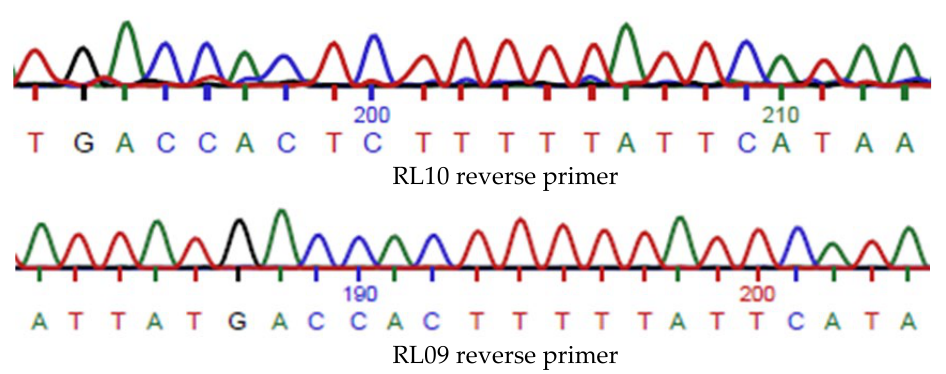
Figure A1. The sequence of the L. crispatus pulA signal peptide region of a pulA + strain RL10 and pulA − strain RL09.